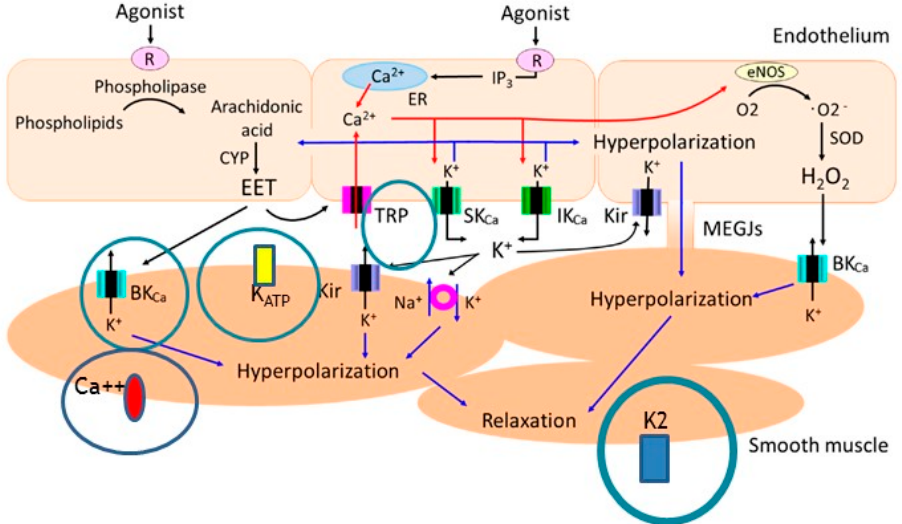
Figure 4. The ion channels affected by omega-3 fatty acids + metabolites important in the mechanisms of vascular relaxation with a focus on K2 channels (figure adopted from Kenichi Goto, Toshio Ohtsubo and Takanari Kitazono. Endothelium-Dependent Hyperpolarization (EDH) in Hypertension: The Role of Endothelial Ion Channels. Int. J. Mol. Sci. 2018, 19(1), 315; https://doi.org/10.3390/ijms190 10315, accessed on 10 February 2022 and modified by I.D.)